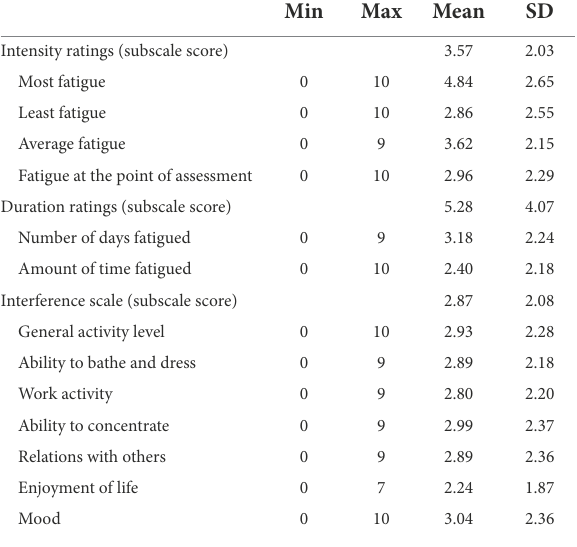
TABLE 4 Liver transplant recipients’ scores on the